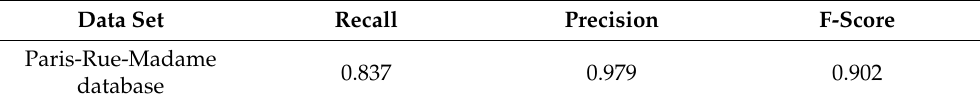
Table 2. The results of recognizing vehicle points on Pari-Rue-Madame database. Data Set